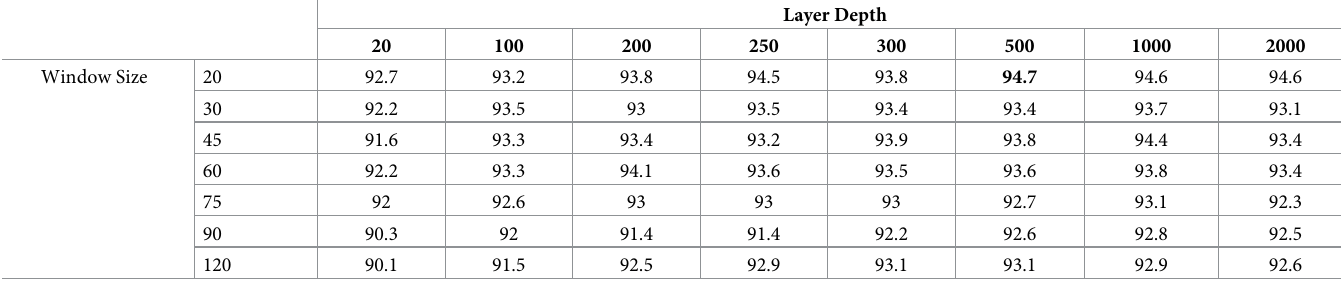
Table 2. 5-fold averages of the test accuracies of the proposed model for various window sizes and layer depths. The highest score is highlighted.